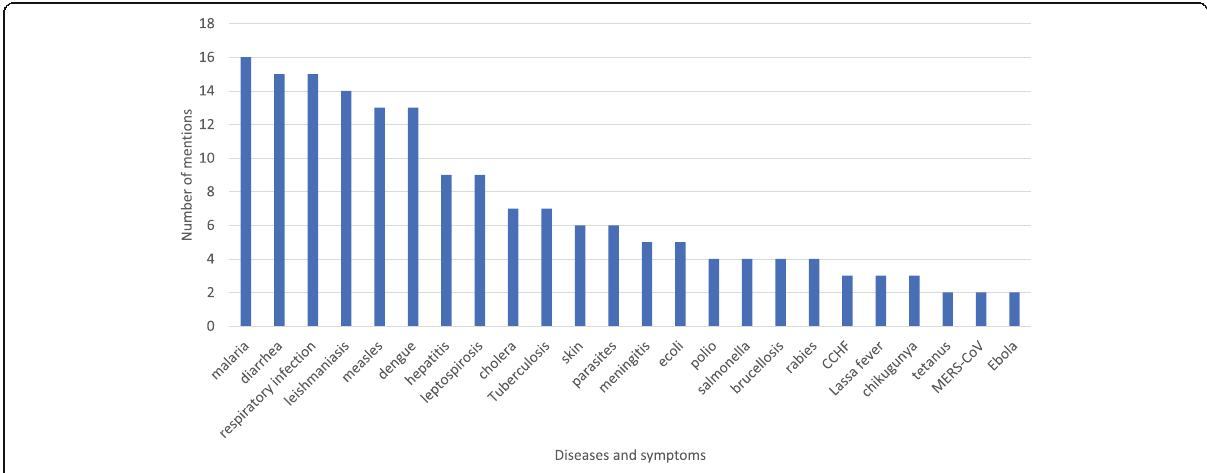
Fig. 5 Symptoms and diseases associated with humanitarian emergencies (as referred to in > 2 independent reviewed